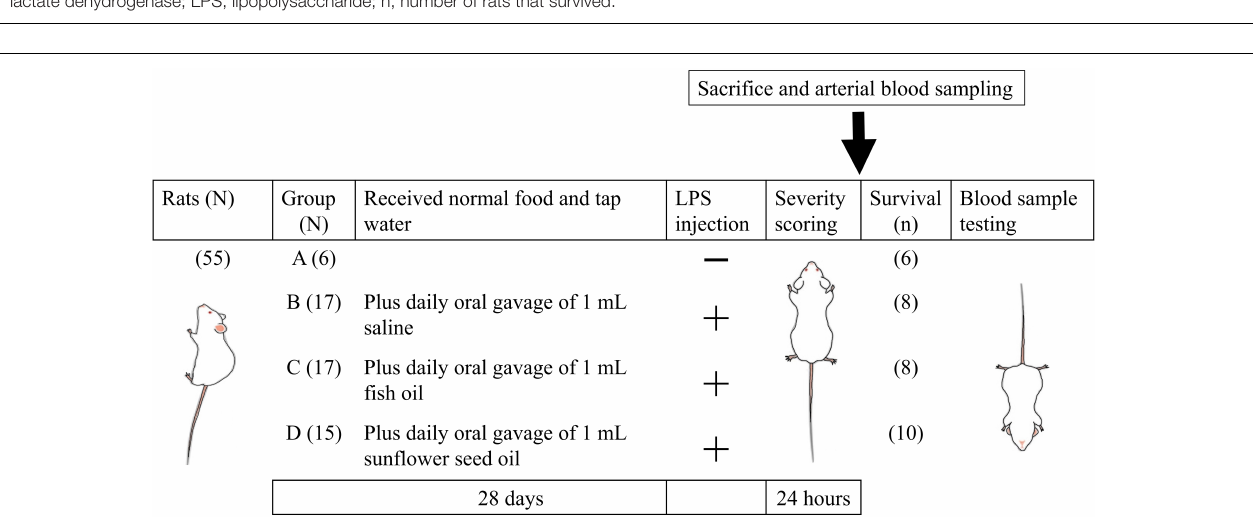
FIGURE 1 | Schematic diagram of grouping and key steps of the study protocol. The rats of all groups were fed normal food and tap water for 28 days, and those in groups B, C, and D were supplemented with daily oral gavage of 1 mL saline, 1 mL fish oil, and 1 mL sunflower seed oil, respectively, for 28 days. On day 29, the rats in all groups, except those in group A, were intraperitoneally injected with Escherichia coli LPS (5 mg/kg body weight). LPS, lipopolysaccharide; N, total number of rats; n, number of rats that survived.